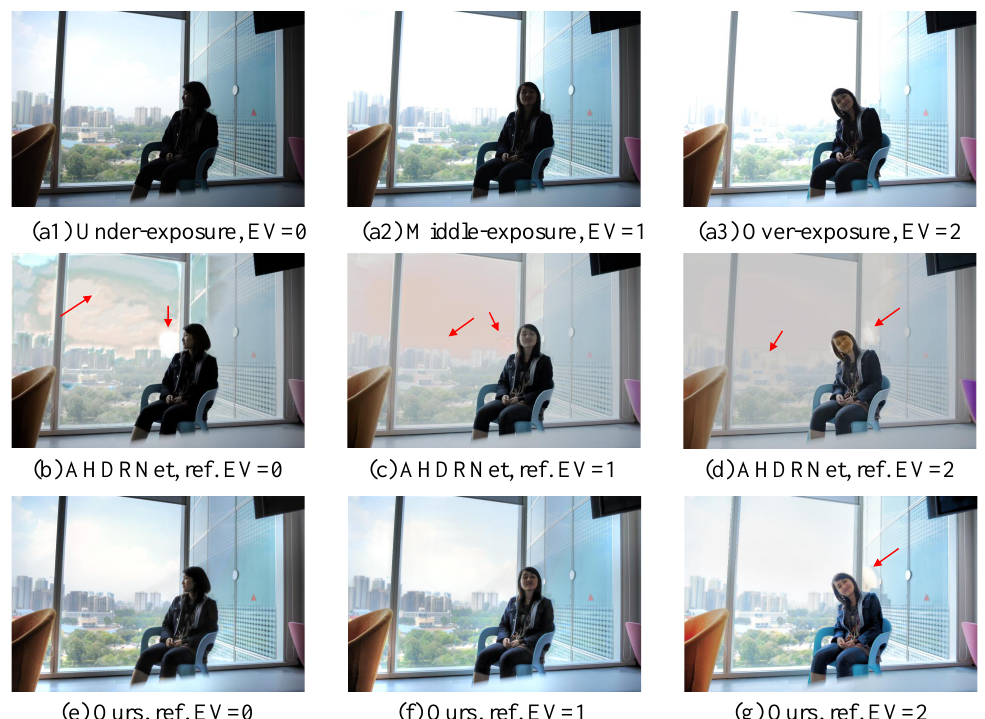
Figure 9. An example of a multi-exposure source image sequence ( a1 – a3 ) and fused images generated by the method in [21] ( b – d ) and our method ( e – g ) using different exposure images as